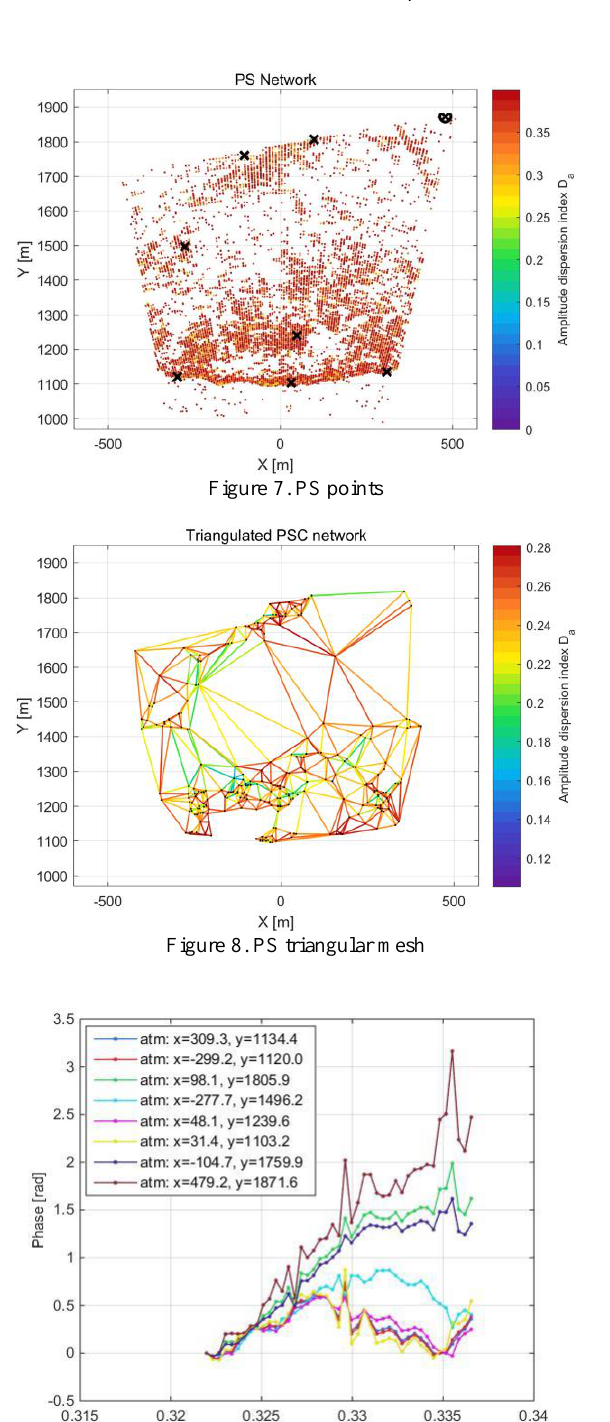
Figure 9. Atmospheric phase of PS points